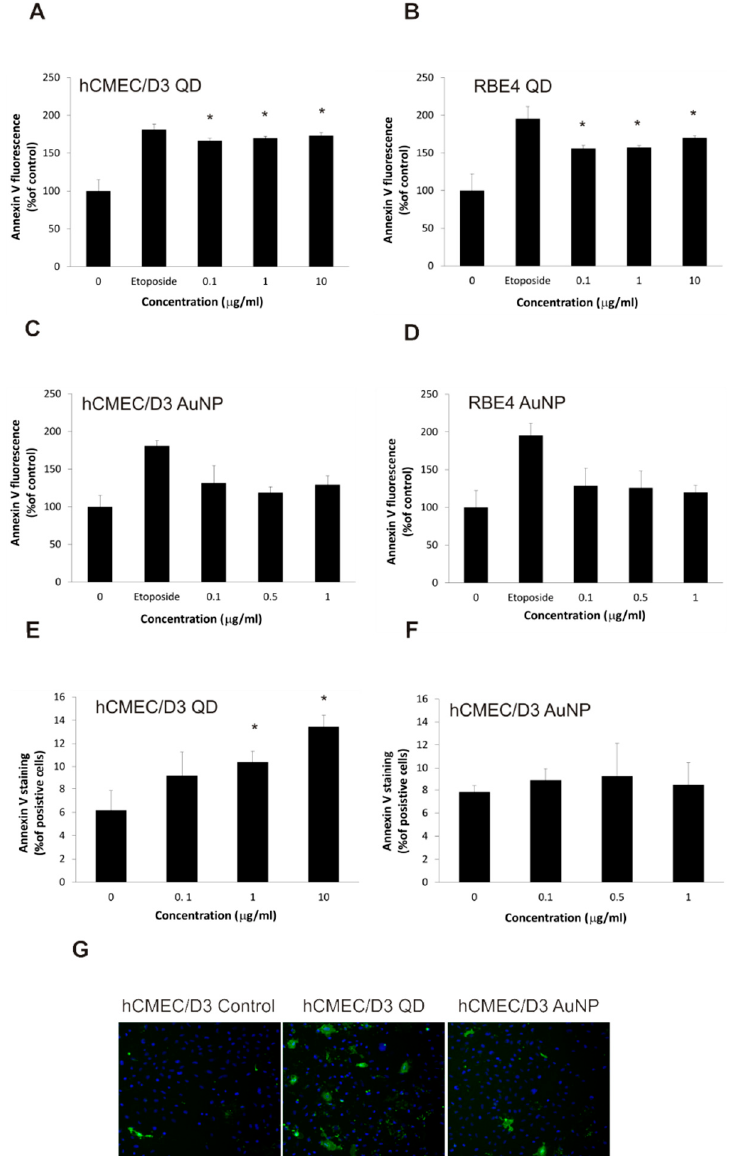
Figure 6. Phosphatidylserine exposure in brain microvascular endothelial cell lines exposed to nanoparticles. Annexin V binding to exposed phosphatidylserine in hCMEC/D3 (panels ( A , C , E , F , G )) and RBE4 (panels ( B , D )) cell lines, treated with QD (panels ( A , B , E , G )) and AuNP (panels ( C , D , F , G )) nanoparticles (as well as positive control etoposide), was assayed by bulk cell fluorescence using the EnVision plate reader (panels ( A – D )) and high content screening using the ArrayScan VTi platform (panels ( E – G )). Values for bulk cell fluorescence were calculated as the percentage of value for control (non-exposed) cells and presented as the average ± S.D. ( n = 4 in panels ( A , B ), n = 3 in panels ( C , D )). Asterisks indicate differences from control (untreated cells) which were statistically significant at p < 0.05. Values for high content screening were calculated as the percentage of positively stained cells and presented as the average ± S.D. ( n = 4 in panel ( E ), n = 3 in panel ( F )). Asterisks indicate differences from control (untreated cells) which were statistically significant at p < 0.05. Panel G shows representative images from the high-content screening